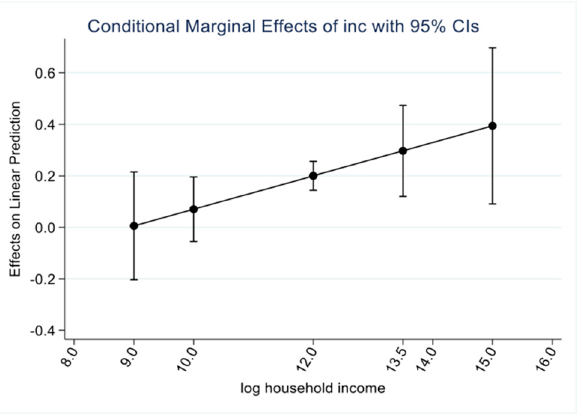
Figure 2. Average marginal effect of income on the household consumption of sugar-free drinks.